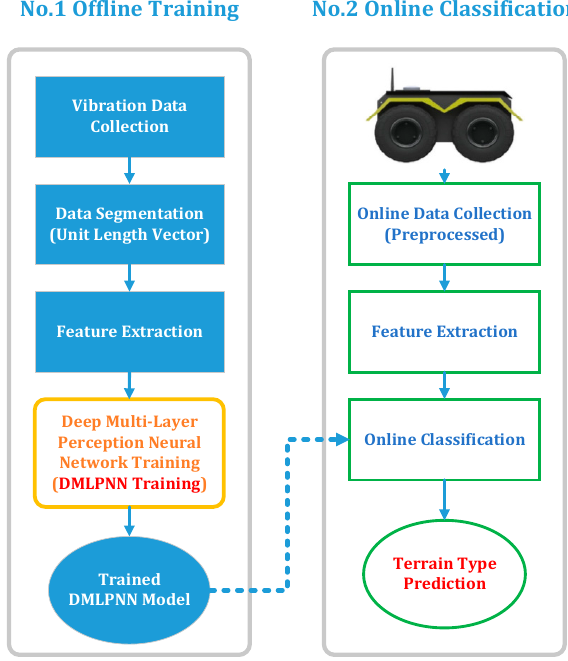
Figure 2. Neural network classification flow chart.